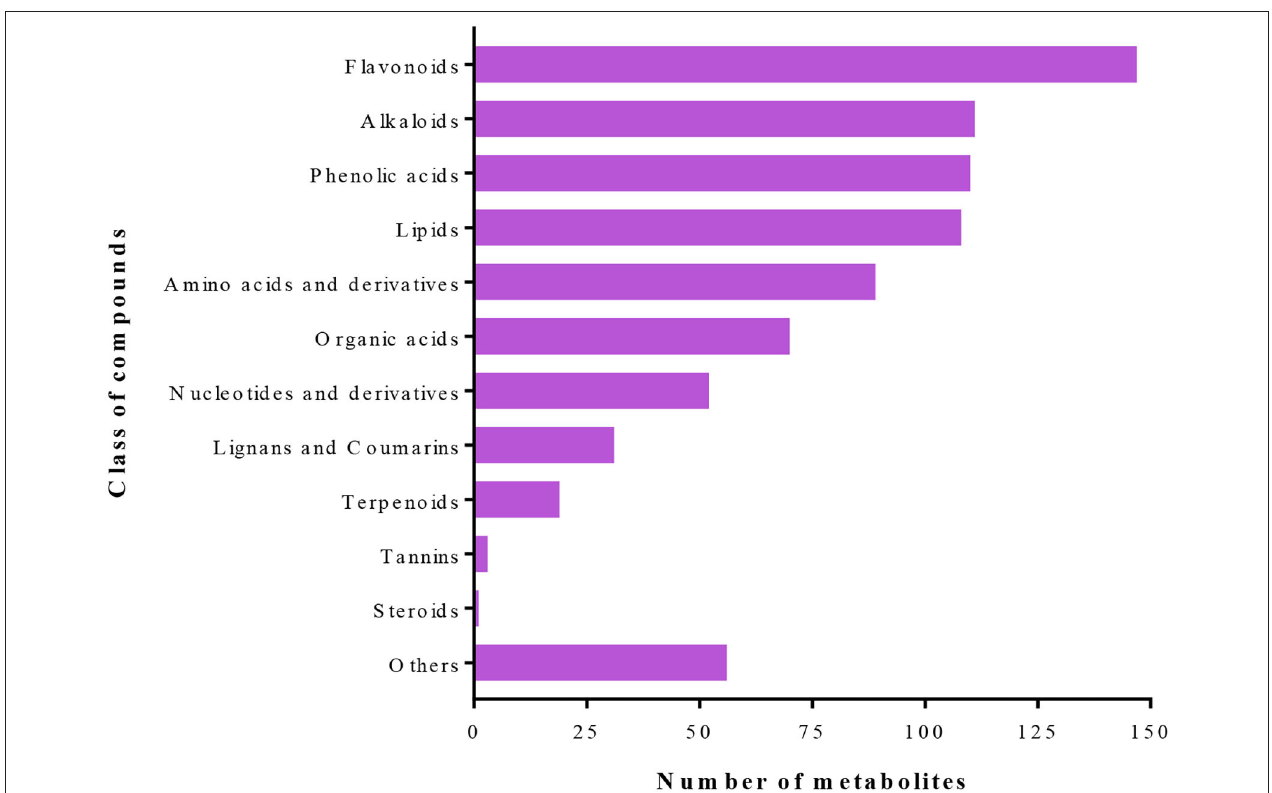
FIGURE 4 | Class of primary/secondary metabolites detected in the leaves of control and infested tomatoes and eggplants.